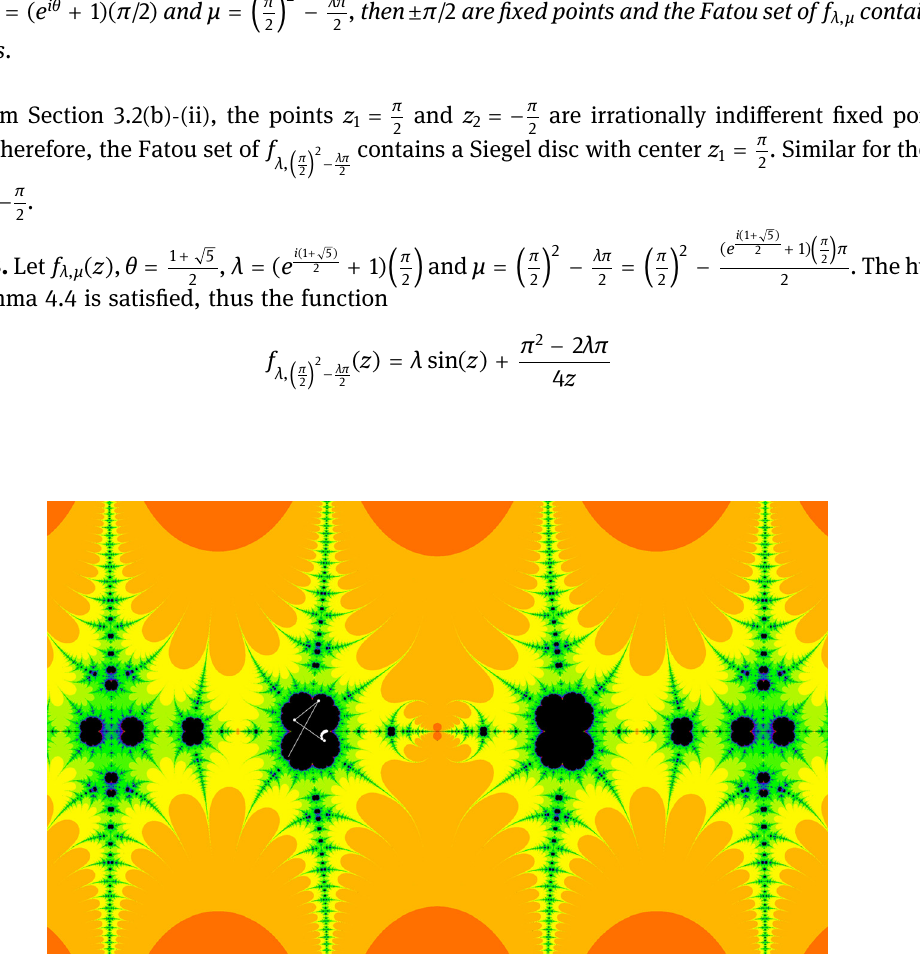
Figure 14: The parabolic domains in the Fatou set of f z